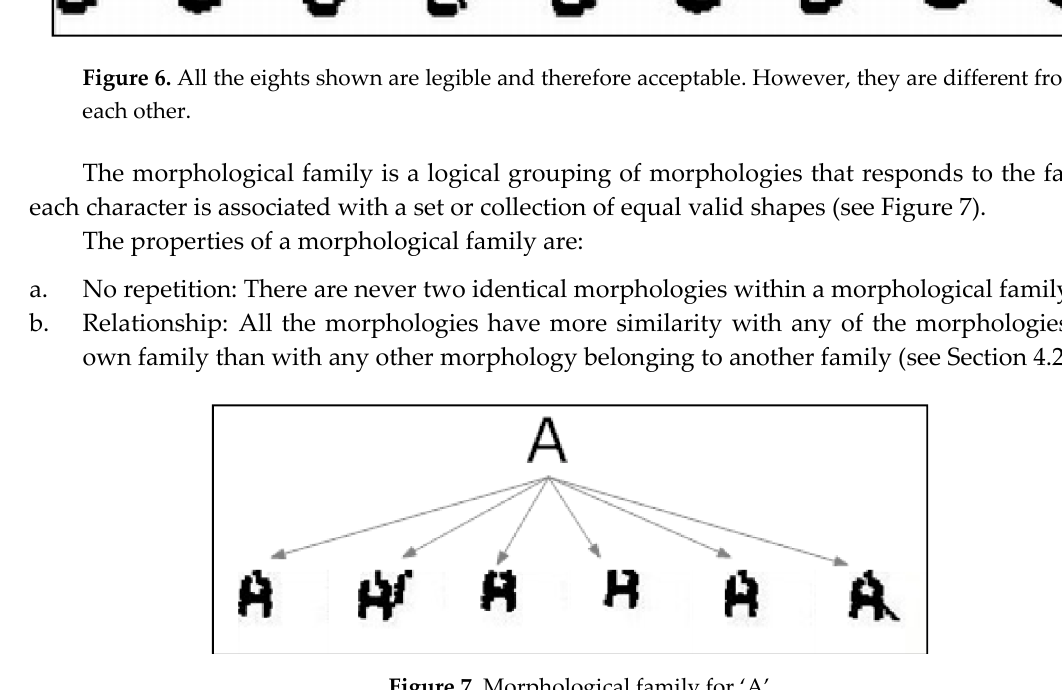
Figure 7. Morphological family for